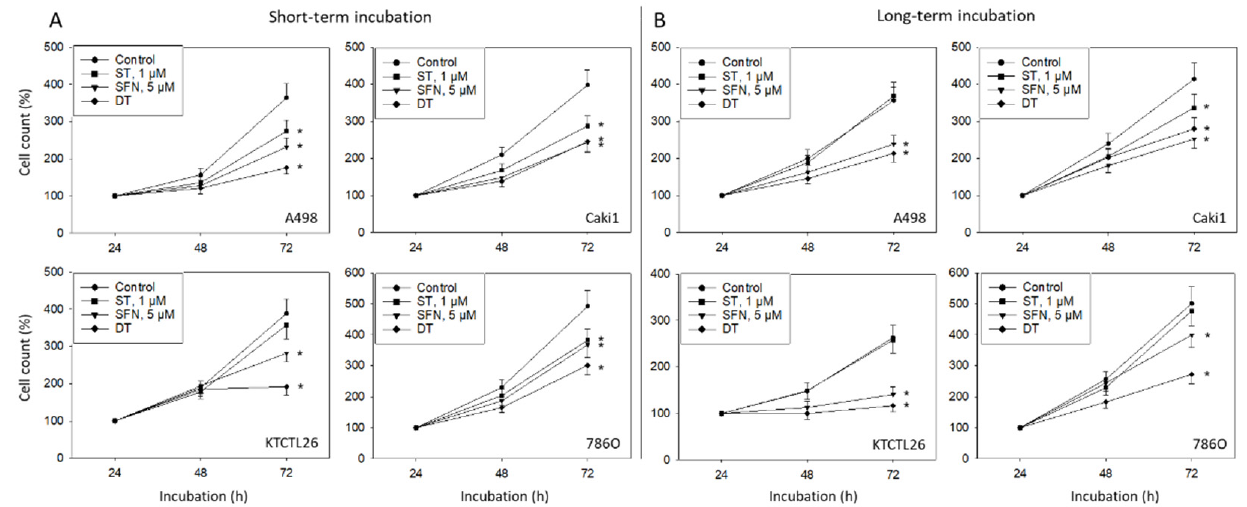
Figure 1. Influence of 1 µ M sunitinib (ST), 5 µ M sulforaphane (SFN), or both (DT) on cell growth in a panel of renal cell cancer cell lines. Cell lines were exposed to the compounds and evaluated after 24 (100%), 48, and 72 h by the MTT assay (short-term incubation, ( A )), or they were preincubated with the compounds for 8 weeks and then re-exposed to them before being subjected to the MTT assay (long-term incubation, ( B )). Cell number after 24 h is depicted in Supplement (Figure S1). Error bars indicate standard deviation, * indicates significant difference to untreated controls set to 100%. n = 6. Clones were only evaluated on A498, KTCTL26, and 786O cell cultures, since Caki1 did not form clones. ST did not alter clone number, whether it was applied short- or long-term (Figure 2A). A marked clone loss was apparent in the presence of SFN or DT. ST only moderately reduced BrdU incorporation in Caki1 and KTCTL26 cells following short-term application (Figure 2B upper), whereas BrdU incorporation increased in all cell lines (excepting 786O) after chronic ST exposure for 8 weeks (Figure 2B lower). In contrast, both SFN and DT diminished BrdU uptake in all cell lines under short-term and long-term conditions. DT was even superior to the SFN mono-treatment in 786O cells when exposed chronically over 8 weeks (Figure 2B